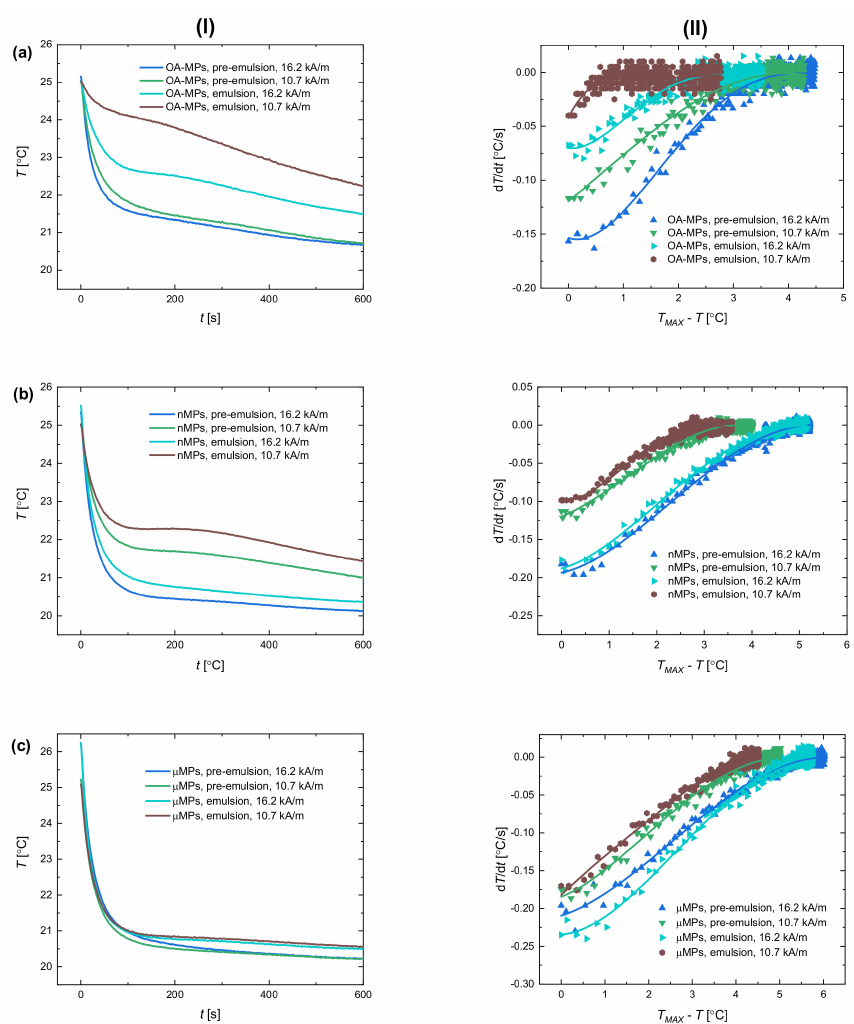
Figure 6. ( I ) The temperature versus time during cooling down after heating and ( II ) the temperature change rate versus temperature di ff erence after magnetic heating for pre- and emulsions stabilized with ( a ) OA-MPs, ( b ) nMPs, and ( c ) µ MPs particles for measurements under the AC magnetic field of an amplitude of 10.7 and 16.2 kA / m. The experimental points representing d T / d t (recorded every second) were fitted to polynomial from Equation (2) whose trending lines were added. The mass concentration of silicone oil in relation to castor oil and the concentration of magnetite were the same for each of samples (10% and 2.3%, respectively) and the time when the AC magnetic field was turned on was when the temperature in the sample exceeded 25 ◦ C. The results had uncertainty values of 1–5% that were not presented in the graph for better